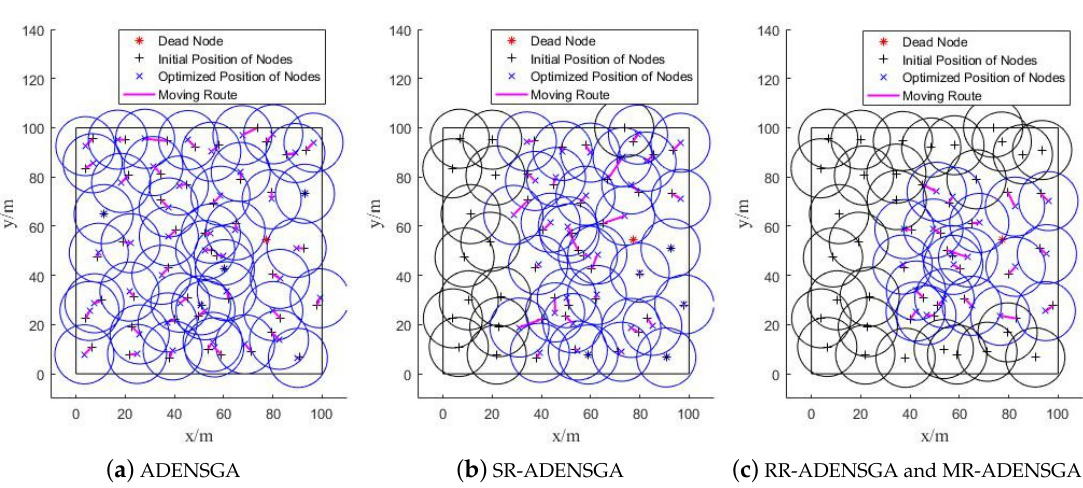
Figure 4. One of the Optimization Solutions to Different Algorithms in Situation